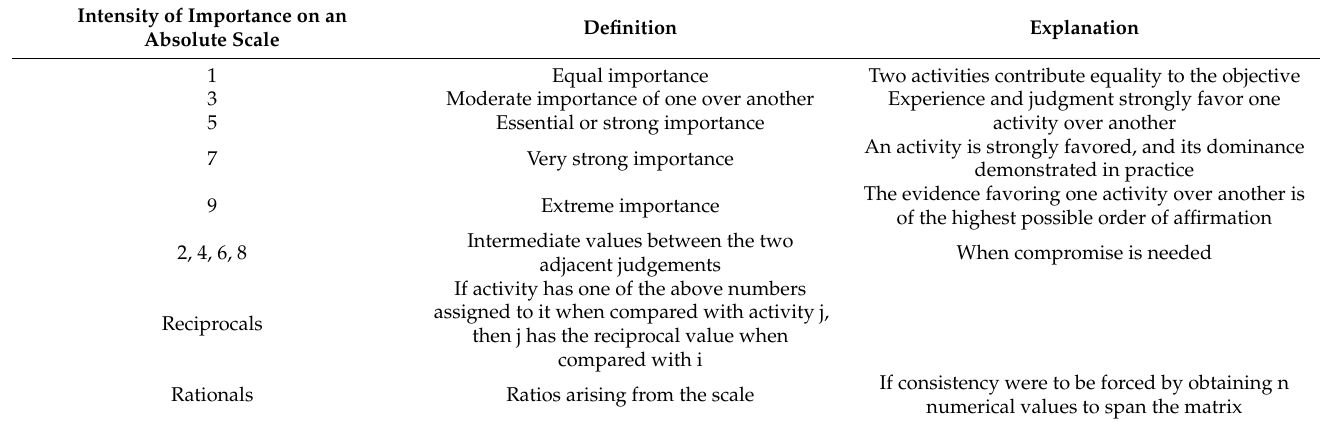
Table 4. AHP fundamental scale [50].